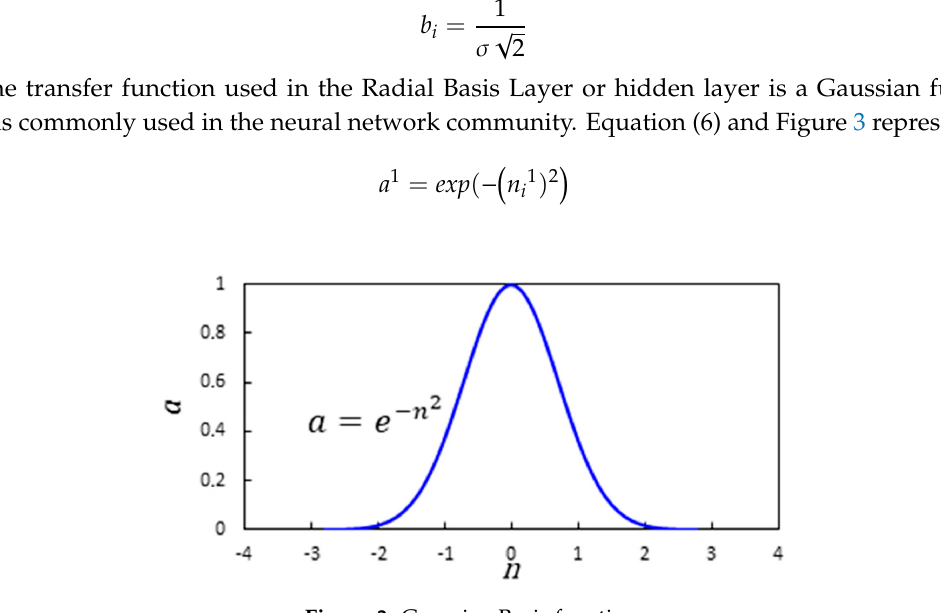
Figure 3. Gaussian Basis function.